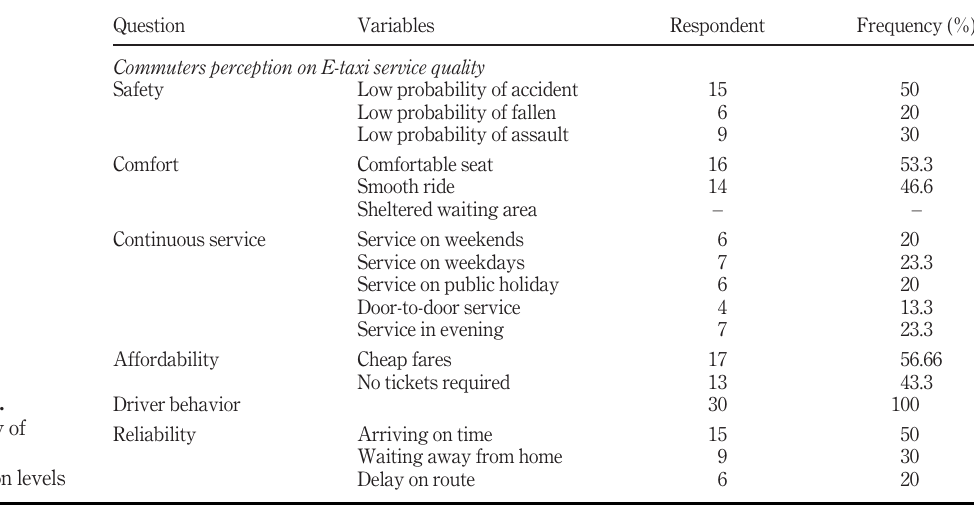
Table IV. Frequency of commuter satisfaction